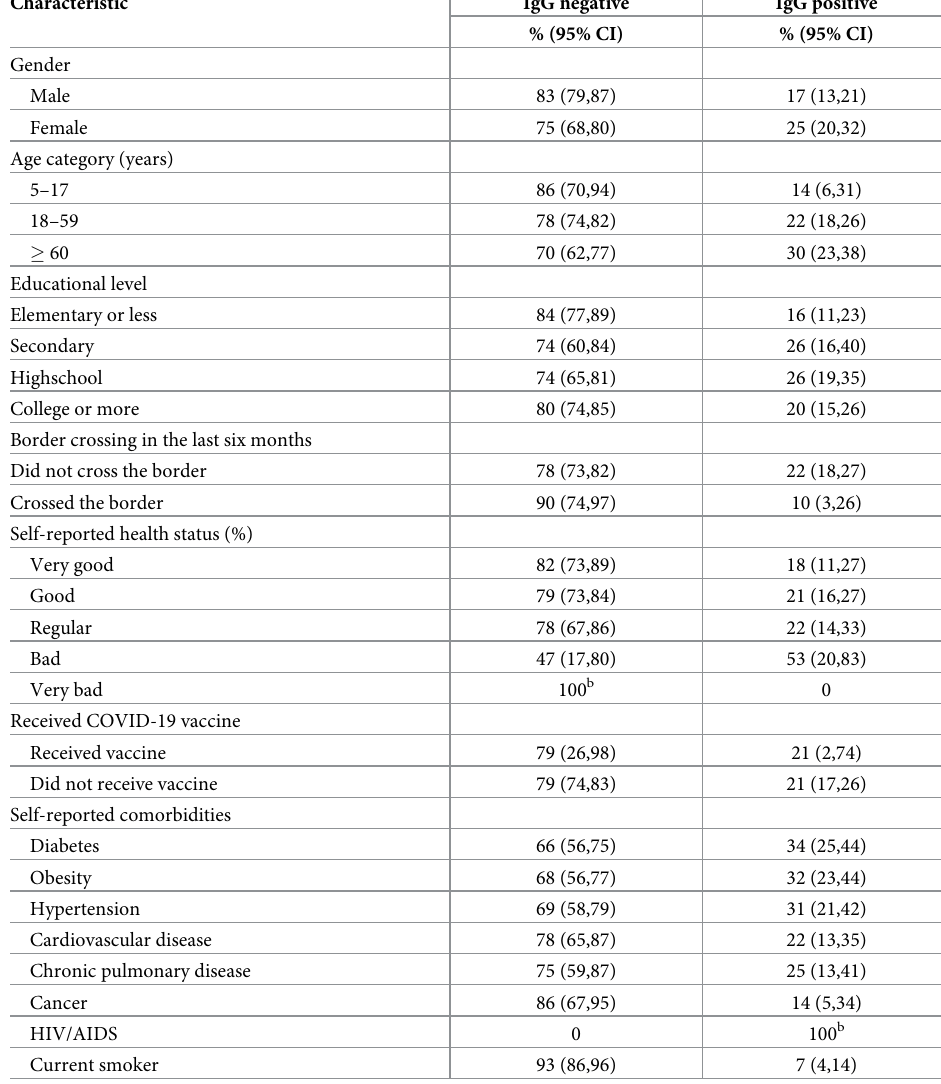
Table 2. Distribution of IgG seropositivity, by participant characteristics, among a community-based sample of Baja California residents–February, 2021 a .